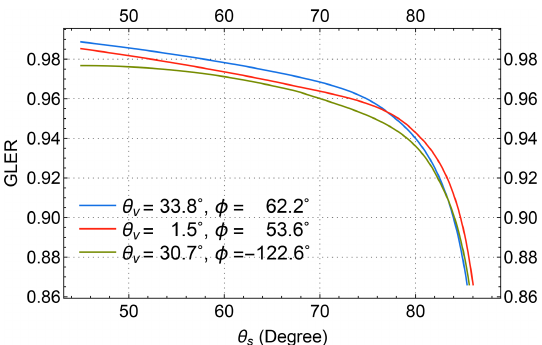
Figure 7. Climatological Antarctic GLER values at 331nm as func- tions of SZA ( θ s ) for three viewing geometries, revealing a signifi- cant dependence of ice GLER on the viewing illumination geome-